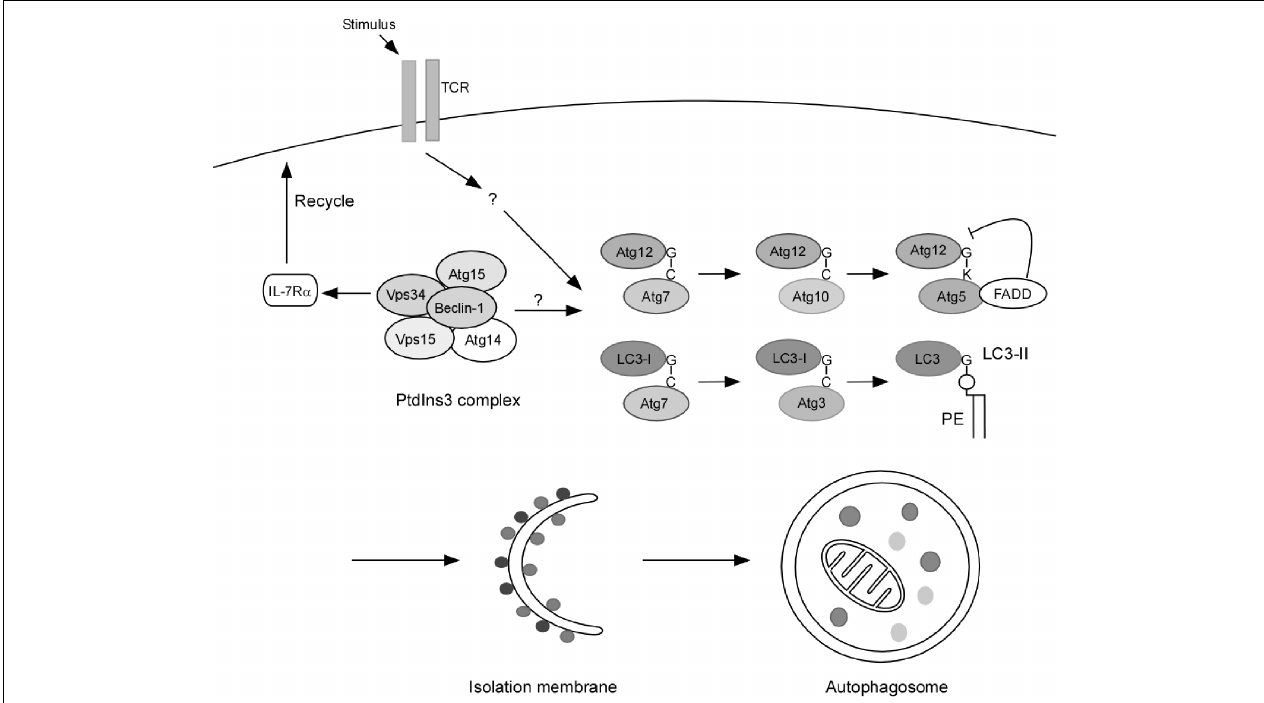
Beclin-1 inT cell autophagy induction remains to be further defined. However, the two autophagosome processing pathways: Atg5–Atg12 conjugation and LC3 processing are essential for autophagy induction as deleting Atg3, Atg5, and Atg7 all results in impaired autophagy inT cells. Furthermore, FADD, the death adaptor protein in the extrinsic death pathway, may play a key role in mediating a crosstalk between the apoptosis and autophagy